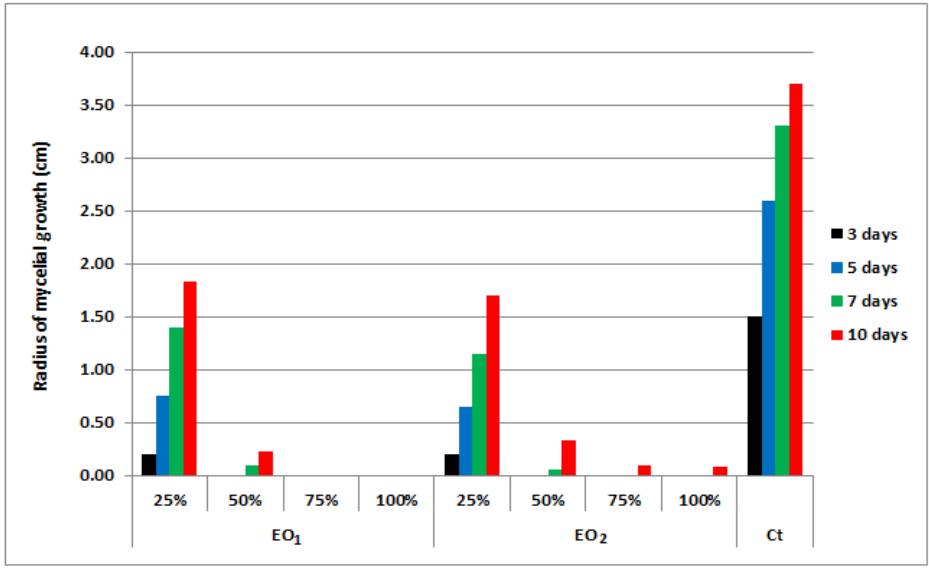
Figure 6. Basil essential oils (EOs) evaluation against the pathogen R. solani on CGA medium, tested at different concentrations.